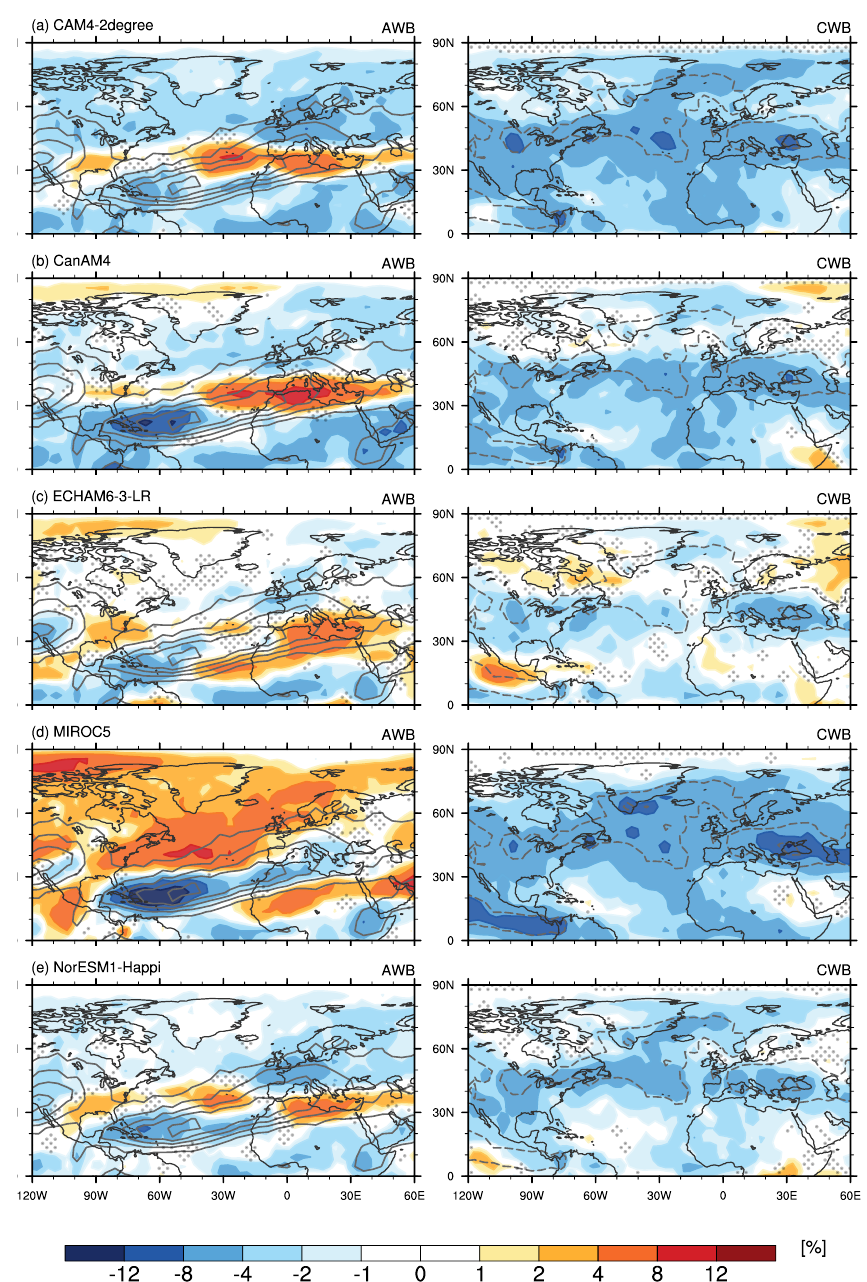
Figure 4. Bias in anticyclonic (AWB, left) and cyclonic (CWB, right) wave breaking for the five HAPPI models. Bias is shown as frequencies (in % of time), while the ERA-Interim climatology for the period 2006–2015 is shown in contours (starting at 10%, in 5% steps, left solid for AWB and right dashed for CWB). Black dots mark biases that are not statistically